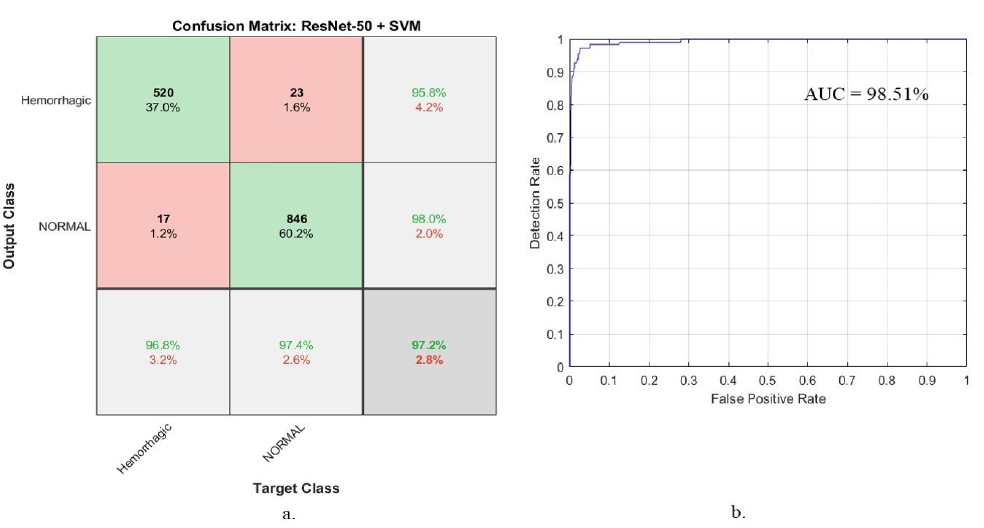
Figure 13. Performance of the ResNet-50 + SVM model for diagnosing the hemorrhage dataset. ( a ) Confusion matrix. ( b )